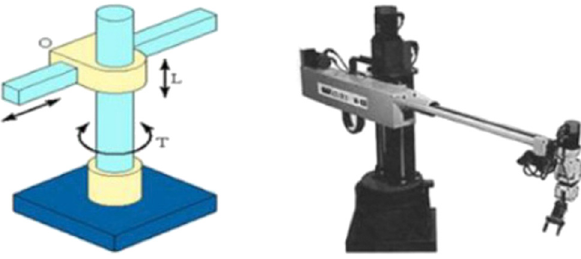
Figure 1: Cylindrical coordination system of a robot [ 13 ] .